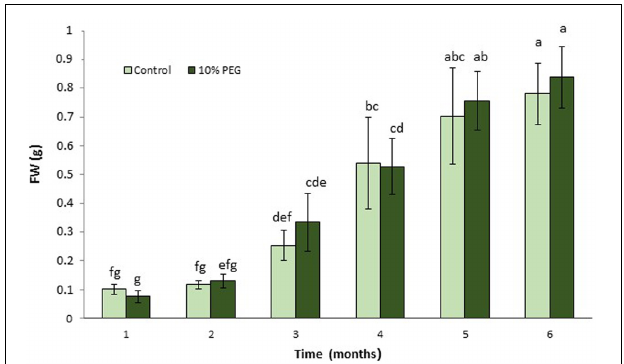
FIGURE 1 | Mean ( ± SD) callus growth over 6 months on MANA medium with 10% w/v PEG compared with control (MANA medium). Different letter combinations indicate significant differences ( P ≤ 0.05; Kruskal–Wallis followed by a Dunn’s test) ( n > 8). See Supplementary File S1 for data and statistical